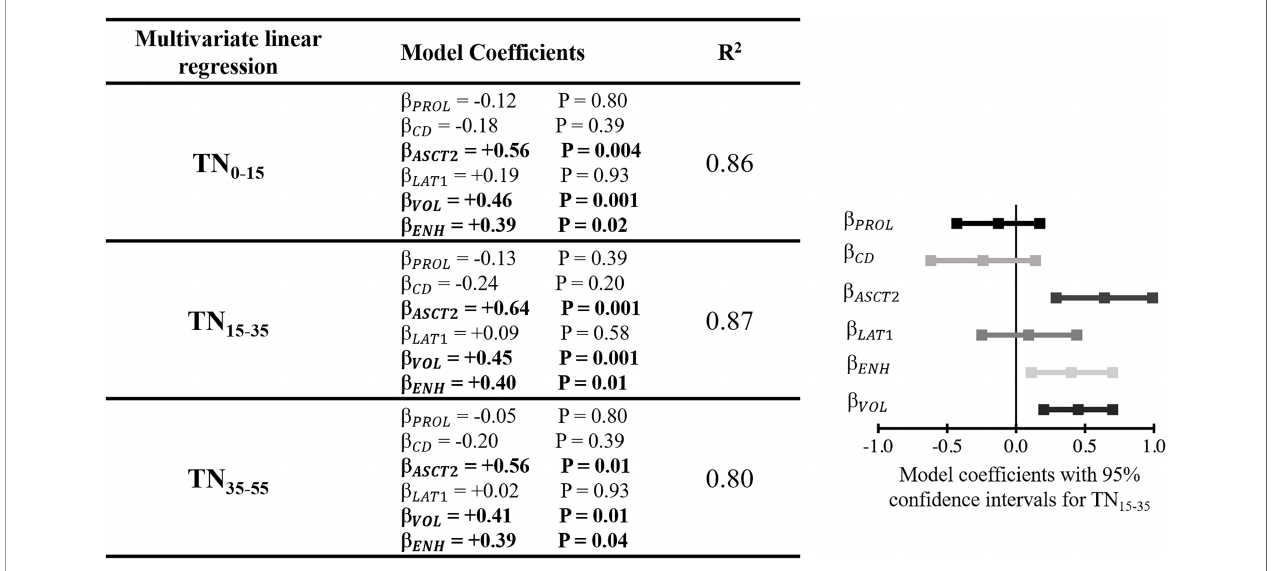
FIGURE 5 | Left) Table showing the multivariate linear regression results with TN as the dependent variable. TN was extracted at three different timepoints after injection and each was included in a separate multivariate linear regression model (indicated by the different rows in the table). Right) Model coef fi cients, including con fi dence intervals, for the fi t estimating TN 15-35 . This qualitatively demonstrates the effect size of variable included within the model. b model coef fi cient for a given variable; PROL, Ki67 proliferative index; CD, cell density; ENH, enhancing tumor; VOL, tumor